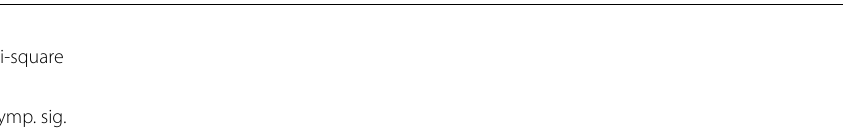
Table 3 Friedman test statistic N Chi-square df Asymp. sig.